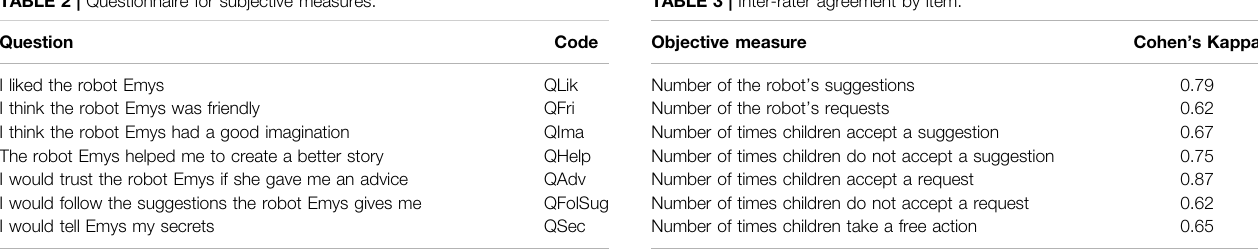
TABLE 2 | Questionnaire for subjective measures. TABLE 3 | Inter-rater agreement by